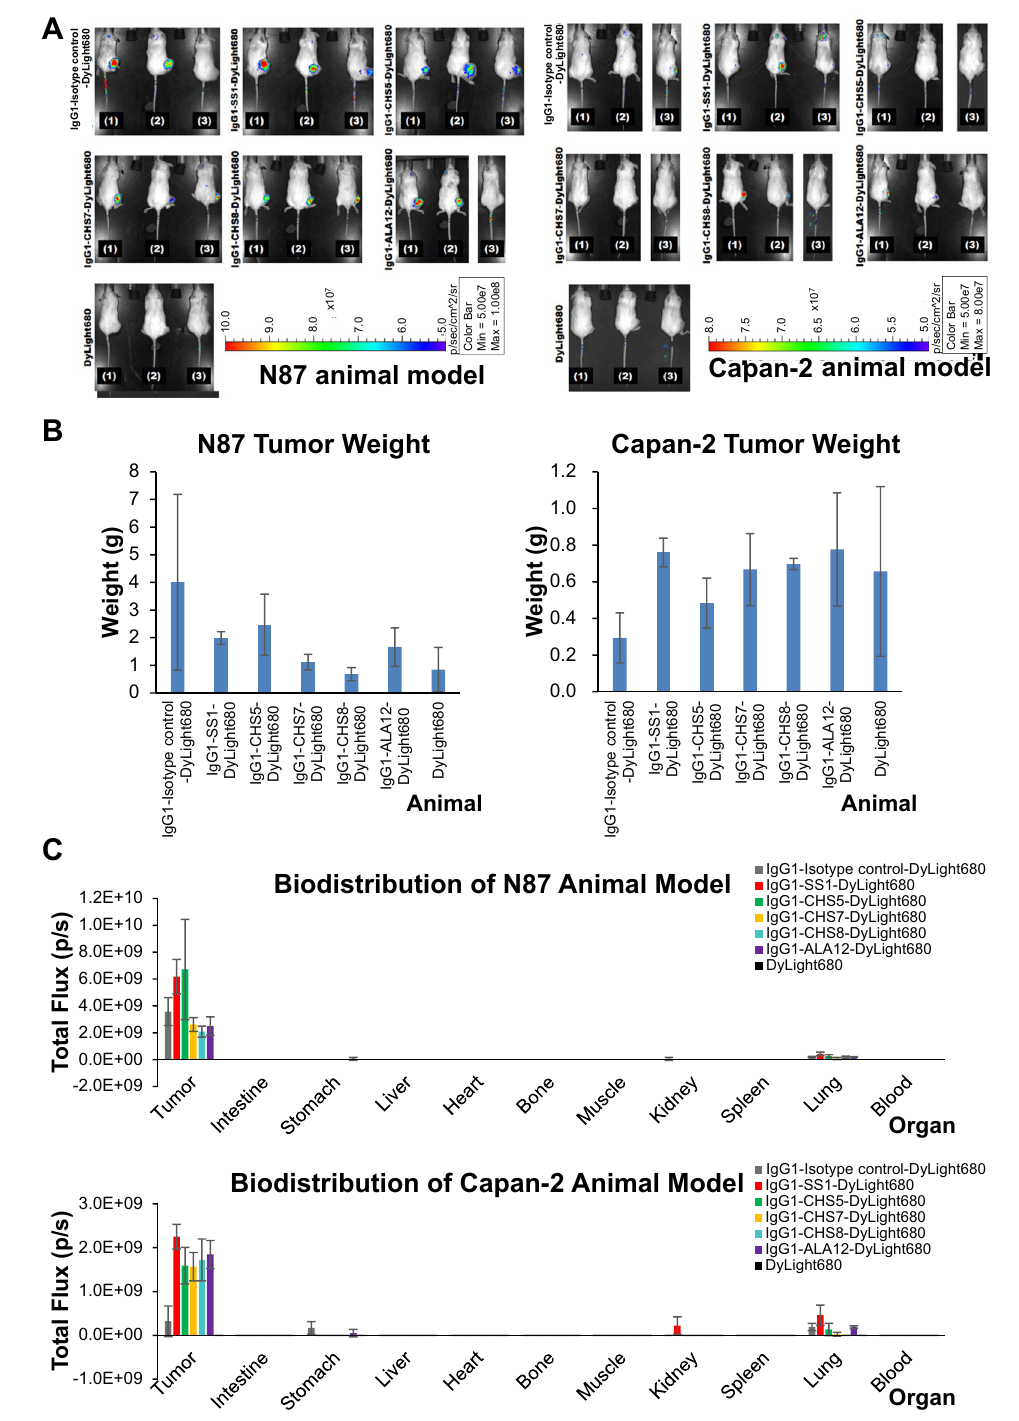
Figure 8. Bio-distributions of the anti-MSLN IgG1s in N87 and Capan-2 xenograft models. ( A ) DyLight 680-labeled anti-MSLN IgG1s of the experimental group (IgG1-CHS5-DyLight 680, IgG1-CHS7-DyLight 680, IgG1-CHS8-DyLight 680 and IgG1-ALA12-DyLight 680), along with the isotype control (IgG1-S40-DyLight 680), positive control (IgG1-SS1-DyLight 680) and negative control (DyLight 680 only), were injected into N87/ Capan-2 tumor-bearing mice and imaged at 24 h post-injection (0.5 nmol, 150 μL per injection) with IVIS. ( B ) The mean value and standard deviation of tumor weight for each of the experimental groups were calculated with the data collected from the three mice in the corresponding experimental group as shown in ( A ). ( C ) Ex vivo quantified bio-distributions of DyLight 680-labeled IgG1 in N87/Capan-2 tumor-bearing mice at 24 h post-injection are shown in the y-axis for the tumors and organs excised from the mice (x-axis). The mean values and standard deviations of bio-distributions were calculated with three mice in each of the experimental groups. The ex vivo images of the tumors and organs with IVIS are shown in Supplementary Figure